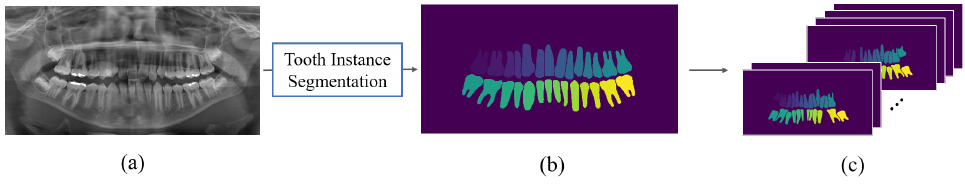
Figure 2. Generation of synthetic data for missing tooth region detection. ( a ) Panoramic radiographic image that contains 28 teeth. ( b ) Teeth mask generated through tooth instance segmentation except third molars. ( c ) Synthetic data generated by randomly removing teeth from a tooth